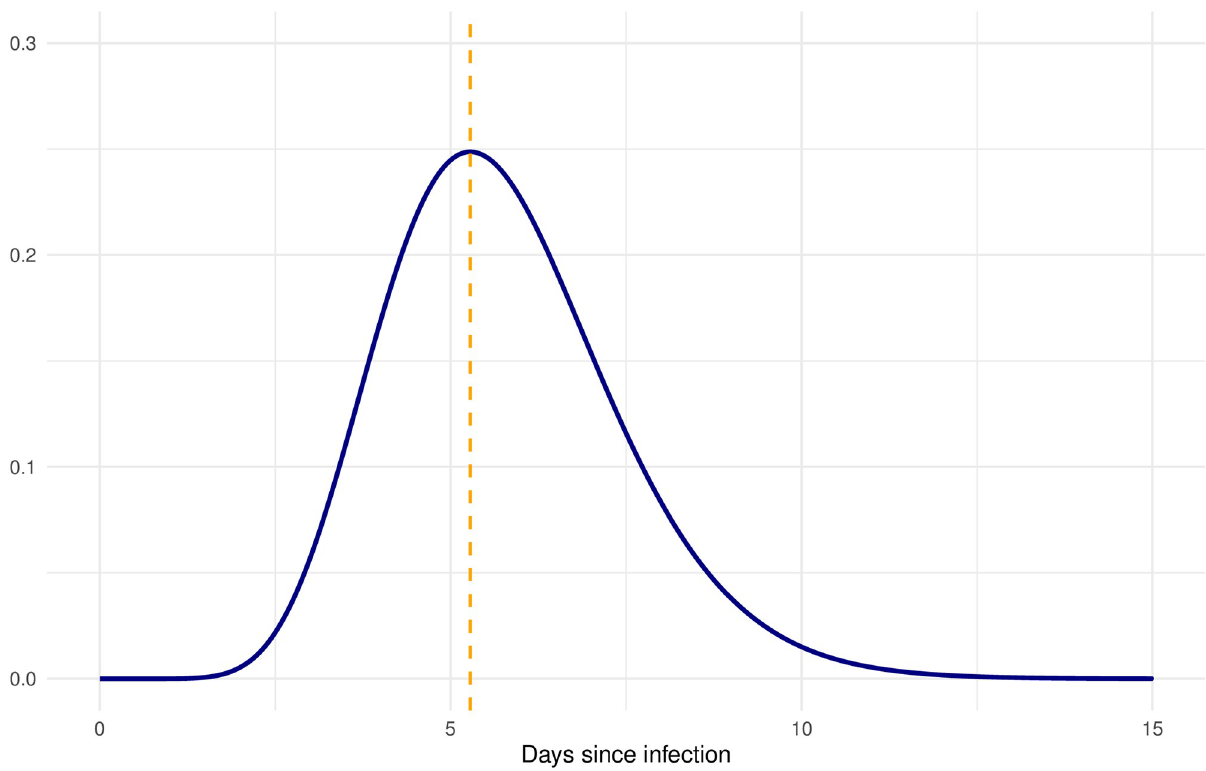
Fig 1. Infectivity measure. Infectivity Measure over the infectious period (blue line) and day of symptom onset (dashed orange line).